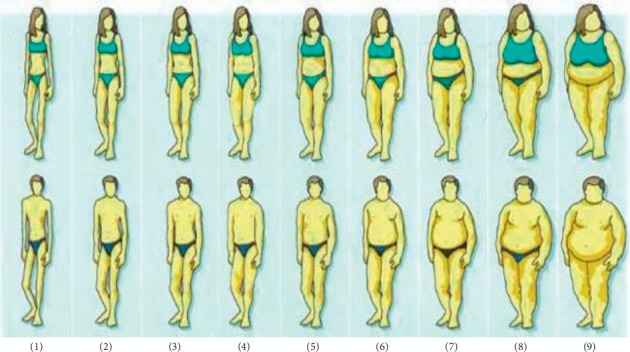
Stunkard figure rating scale [22].